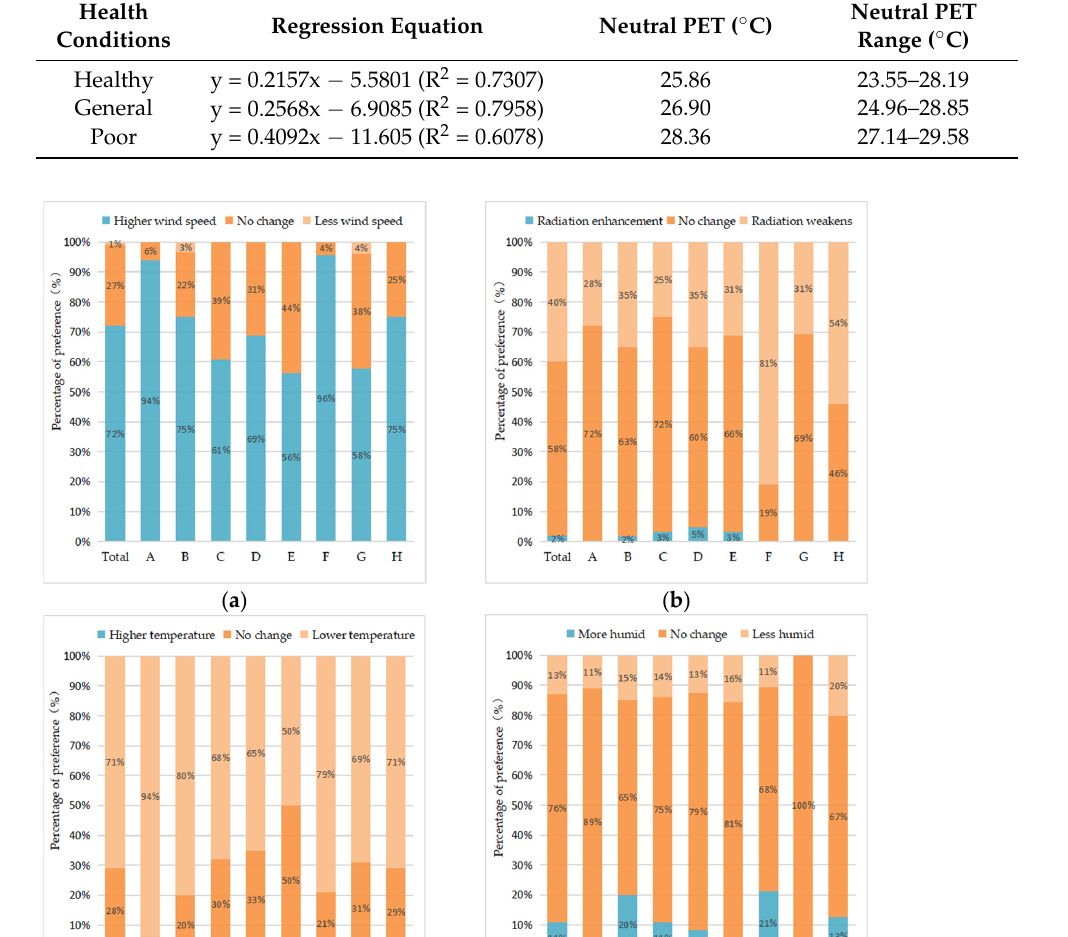
Figure 10. Correlation between MTSV and PET in elderly of different health conditions.